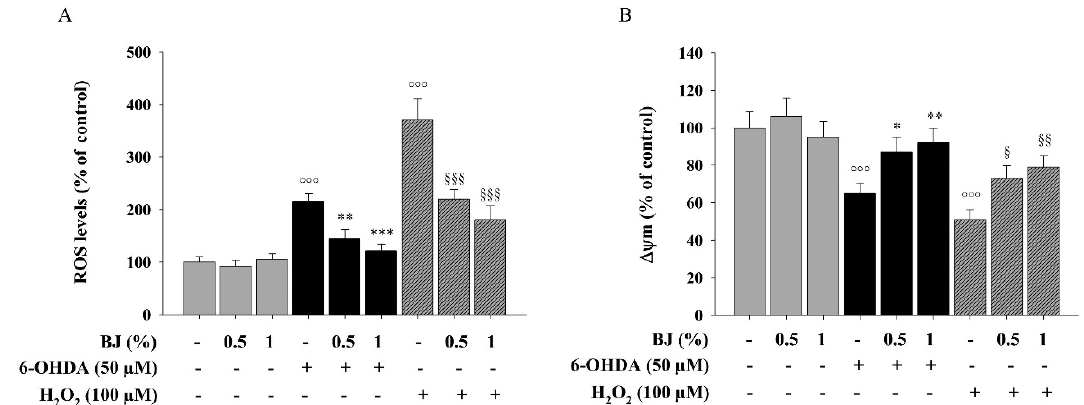
Figure 3. BJ attenuates the accumulation of reactive oxygen species (ROS) and the loss of ∆ ψ m induced by both 6-OHDA and H 2 O 2 . ( A ) ROS generation was measured by a fluorescent method, using DCFH-DA as probe. ( B ) Variations of ∆ ψ m were assessed using the cationic fluorochrome R123. Results are reported as percentage of the levels detected in untreated cells. Data are shown as the mean ± S.E.M. of three experiments. ◦◦◦ P < 0.001 vs. control; *, ** and *** P < 0.05, P < 0.01 and P < 0.001 vs. 6-OHDA-treated cells, respectively; § , §§ and §§§ P < 0.05, P < 0.01 and P < 0.001 vs. H 2 O 2 -treated cells, respectively.